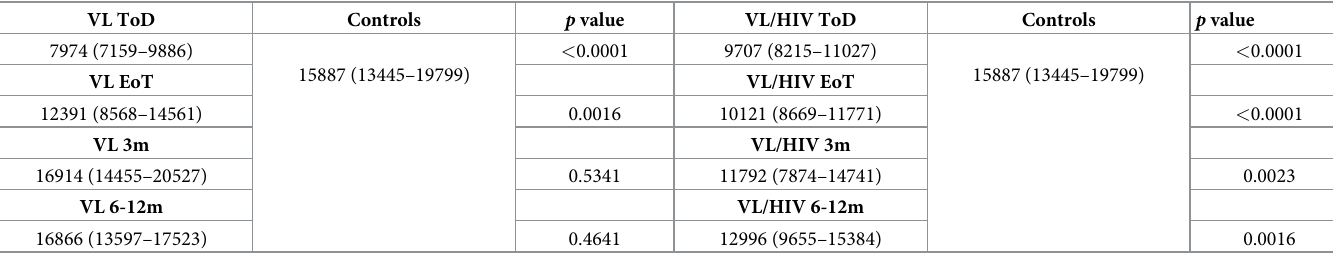
Neutrophils were isolated from whole blood by dextran sedimentation and the expression levels (MFI = Median Fluorescence Intensity) of CD10 on neutrophils from controls (n = 18), VL (ToD: n = 26, EoT: n = 19, 3m: n = 25, 6-12m: n = 29) and VL/HIV (ToD: n = 27, EoT: n = 26, 3m: n = 19, 6-12m: n = 22) patients were measured by flowcytometry as described in Materials and Methods. Statistical differences between VL patients at each time point during follow-up and controls; and between VL/ HIV patients and controls at each time point during follow-up and controls were determined using a Mann-Whitney test. Results are presented as median with interquartile